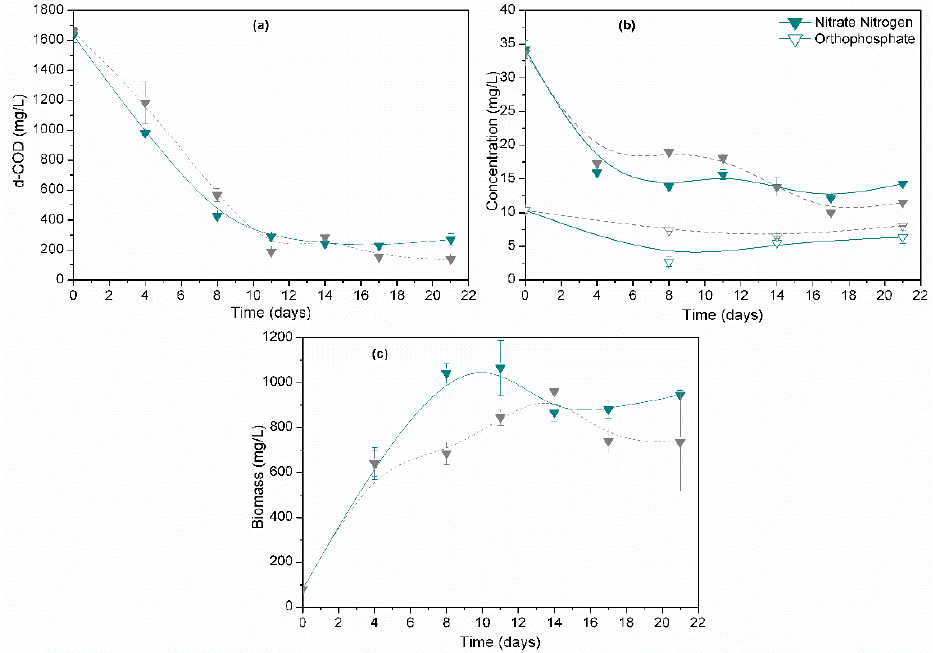
Figure 4. ( a ) d-COD consumption, ( b ) NO 3 − -N and PO 43 − -P consumption, and ( c ) growth of total biomass applying photoperiod (16:8 h light:dark) during A. platensis cultivation in brewery wastewater with 1 g/L NaCl and 5 g/L NaHCO 3 . Data present mean values of duplicate experiments ± standard deviations. Grey symbols with dash lines represent the experiments conducted using the same brewery wastewater-based medium under continuous illumination.